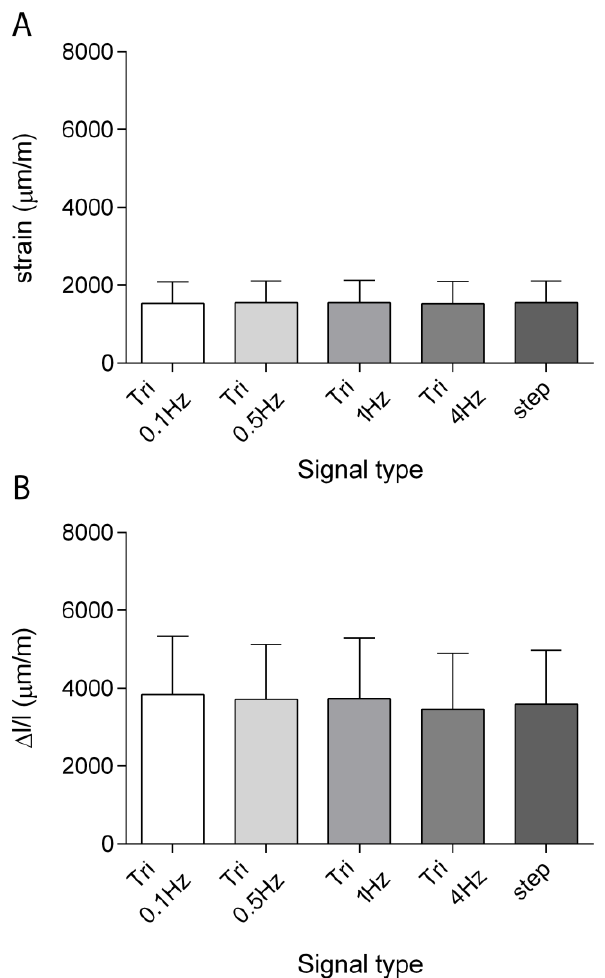
Figure 5. Means ± SDs of the longitudinal strains measured with the micro strain gauge ( A ) and of the global shortening measured through the length transducer ( B ). n = 5.